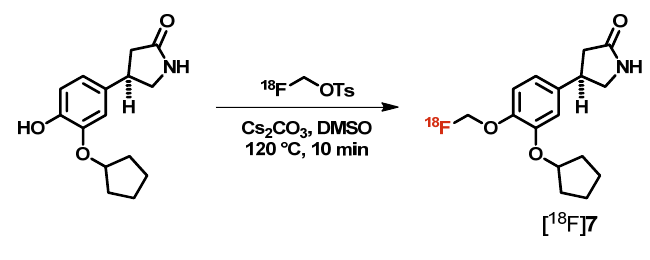
Scheme 4. Radiosynthesis of [ 18 F] 7